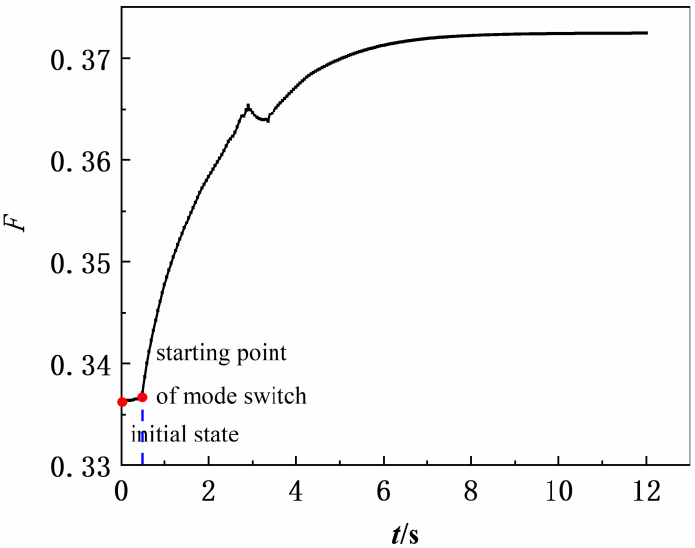
Figure 17. Change curve of thrust of working-mode switching from double bypass to single bypass at H = 11 km, Ma = 1.2.